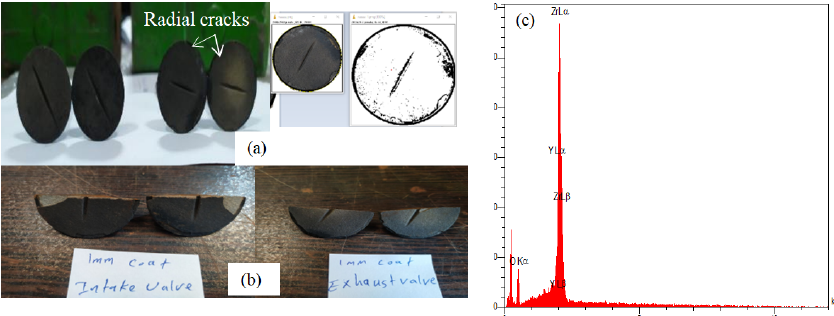
Figure 22: (a) 500 µ m, 1000 µ m coat at the end test, (b) cutting of 1000 µ m intake and exhaust valves after wire cutting machine and (c) EDS 1000 µ m exhaust